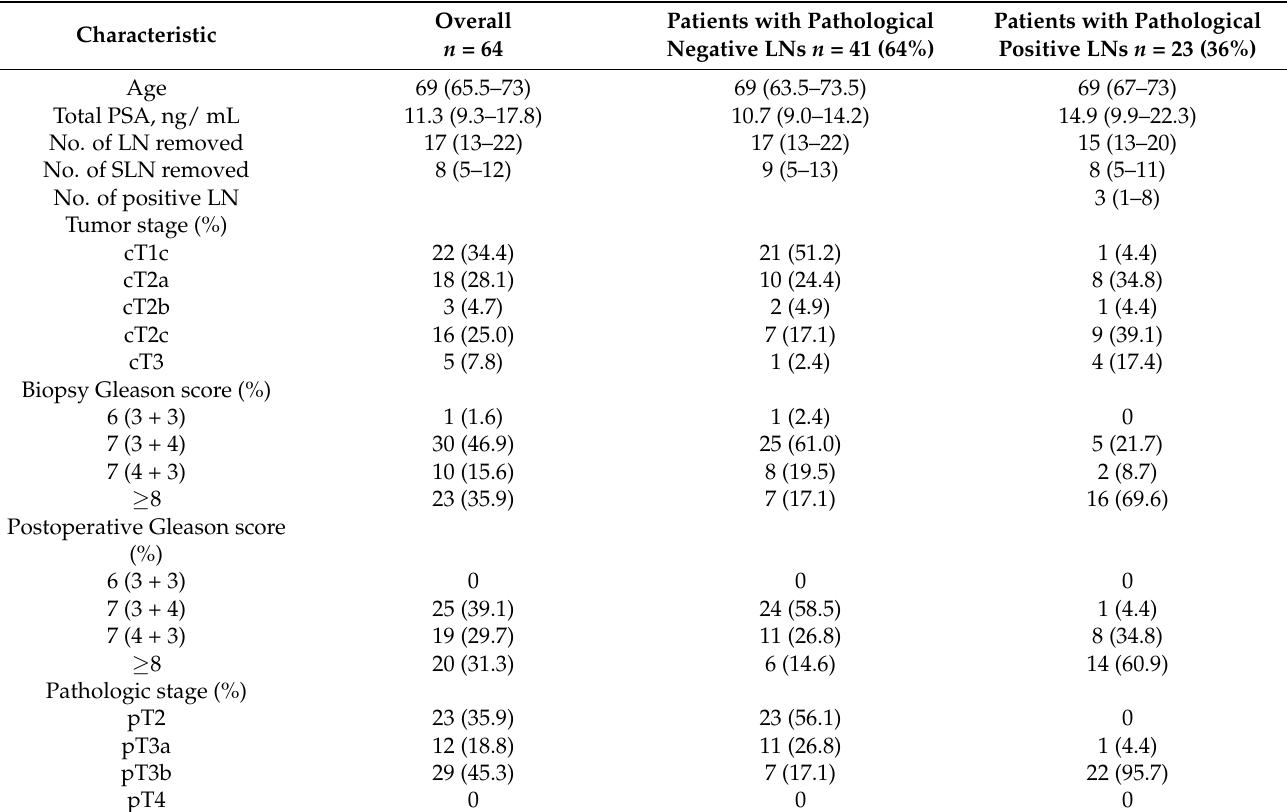
Table 1. Patient